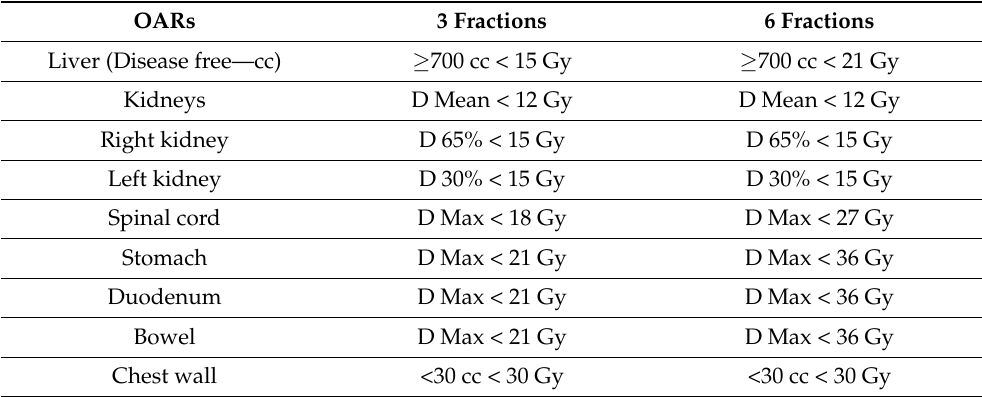
Table 1. Organs at risk’s dose constraints for liver lesions.